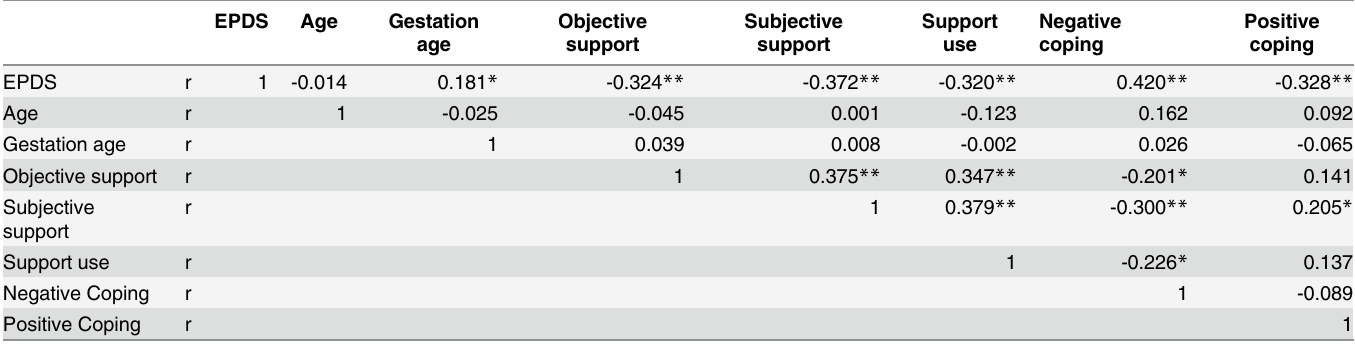
Table 4. Bivariate correlation analysis of scores in EPDS, social support, and coping styles, and of demographic